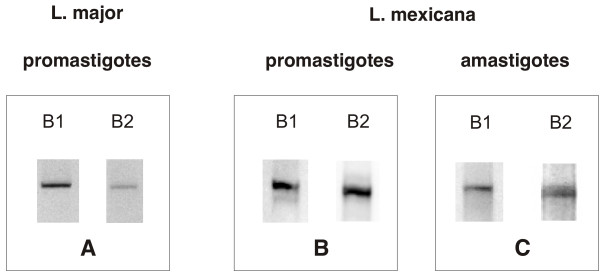
Northern blots. Total RNA from L. major promastigotes (panelA), L. mexicana promastigotes (panel B) and L. mexicana amastigotes (panel C) was fractionated on agarose gels, and the RNA-filters were hybridized with DIG-labelled DNA probes for LmjPDEB1 (B1) and LmjPDEB2 (B2). The sizes of the two mRNAs were 5.3 Kb and 4.9 Kb for B1 and B2, respectively.